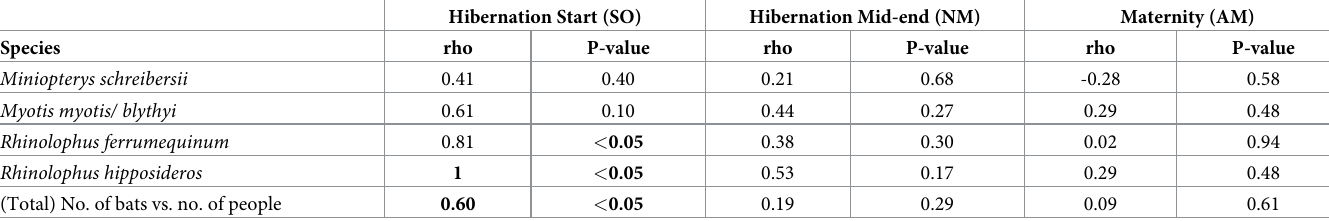
Table 4. Spearman’s correlation matrix, comparing species abundance per roost with the number of tourists’ passes per activity period. Hibernation Start